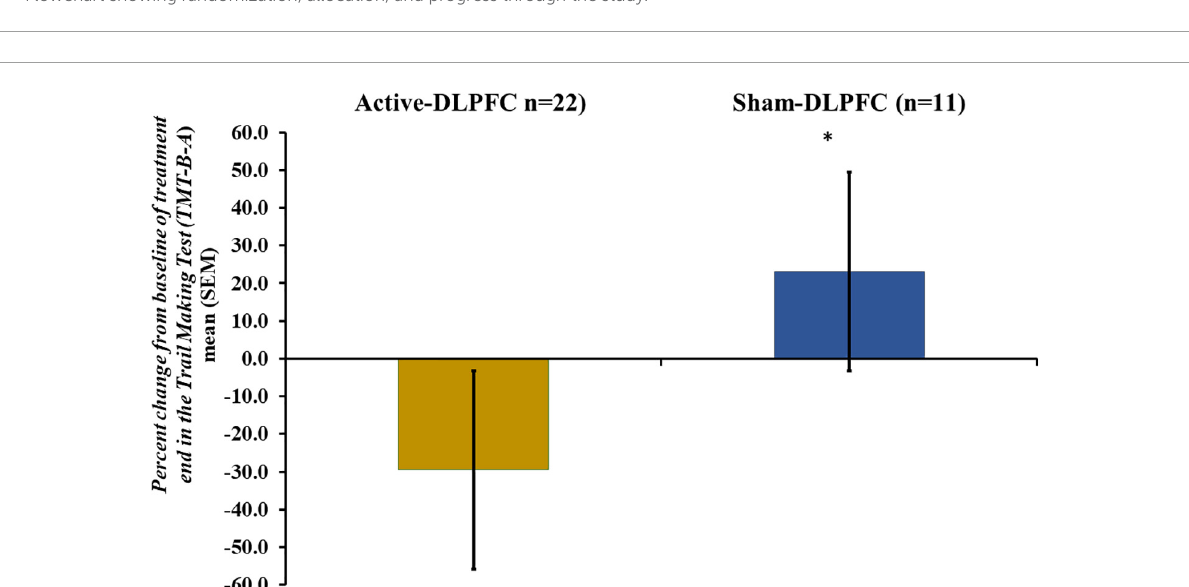
FIGURE3 Mean of percent changes of averages from the pre-intervention period to treatment end period of the total score in the Trail Making Test (TMT-B-A). Error bars indicate the standard error of the mean (SEM). Asterisks (*) positioned above symbols indicate significant differences ( p < 0.05) between groups (a-tDCS and